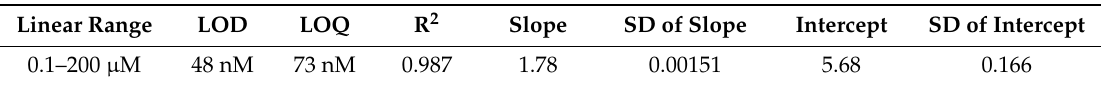
Table 2. Analytical parameters of the calibration straight of biosystem A. LOD: limit of detection, LOQ: limit of